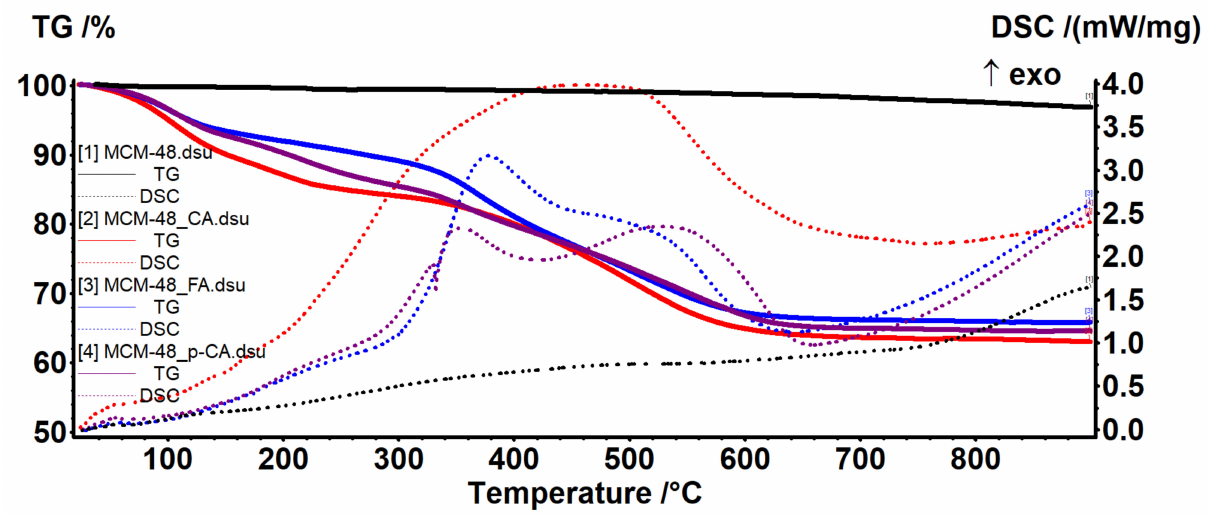
Figure 13. TG–DSC curves for MCM-48, pristine and loaded with polyphenols.